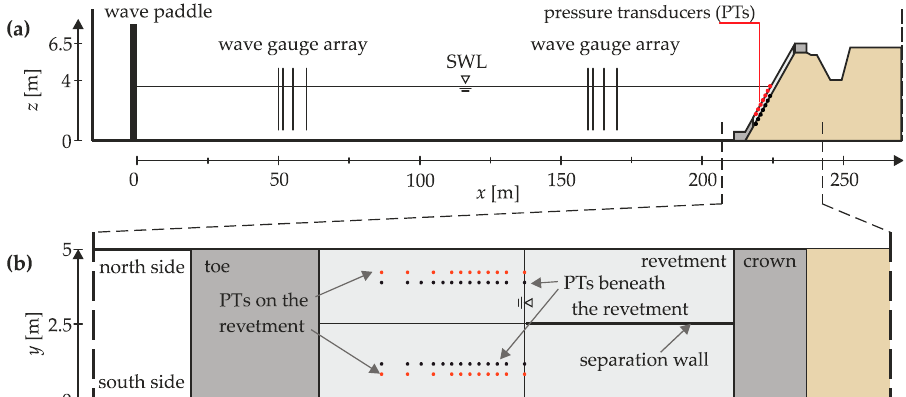
Figure 4. ( a ) Schematic longitudinal cross ‐ section of the GWK showing the wave paddle at the left, the instrumentation along the flume and the revetment on the right. ( b ) Top view of the revetment section with the pressure transducers on and beneath the top layer in red and black, respectively.